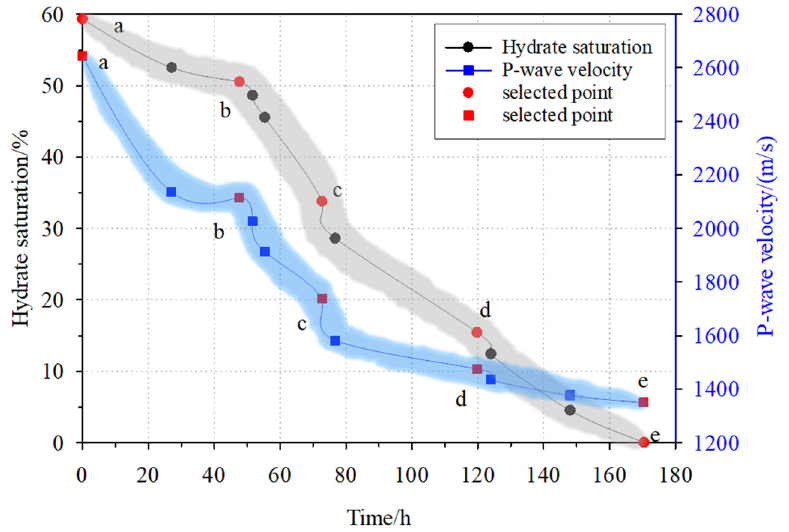
Figure 6. Variation in hydrate saturation and wave velocity during hydrate dissociation. a–e represent different dissociation stages, corresponding to the points in Figures 2–4.